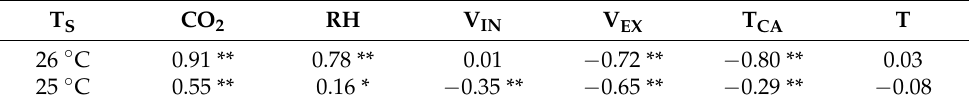
Table 1. Correlation matrix based on hourly data for the NH 3 with CO 2 , RH, V IN , V EX , T CA , T for T S 26 ◦ and 25 ◦ C. T S CO 2 RH V IN V EX T CA T 26 ◦ C 0.91 ** 0.78 ** 0.01 − 0.72 ** − 0.80 ** 0.03 25 ◦ C 0.55 ** 0.16 * − 0.35